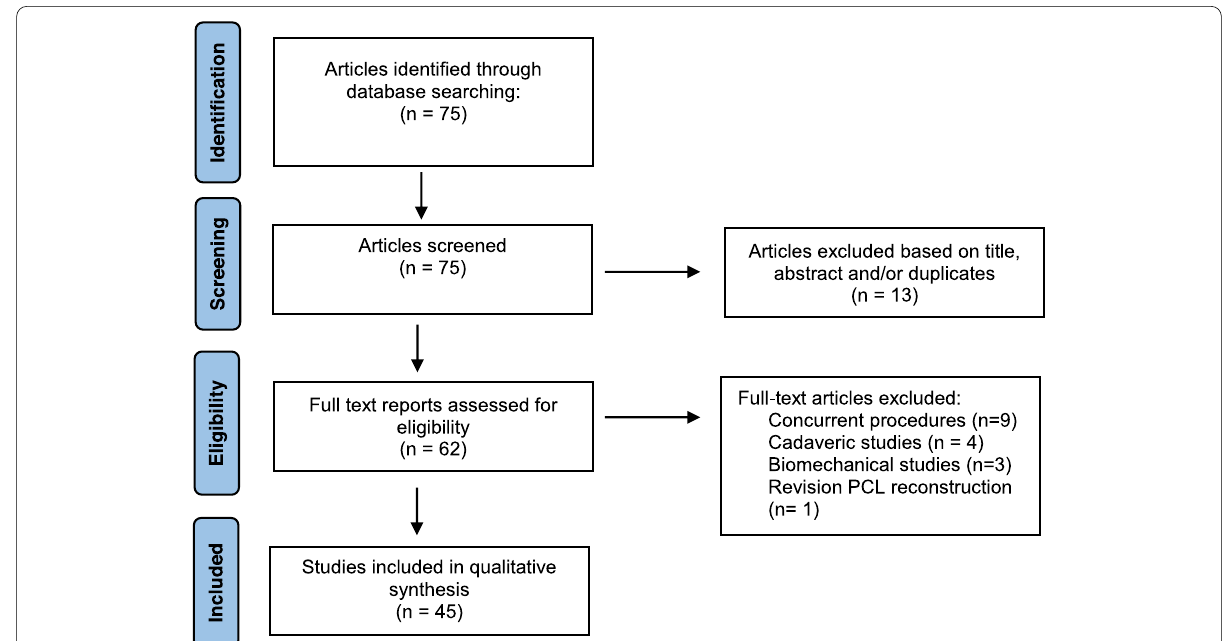
Fig. 1 Preferred Reporting Items for Systematic reviews and Meta-Analyses (PRISMA) flowchart of